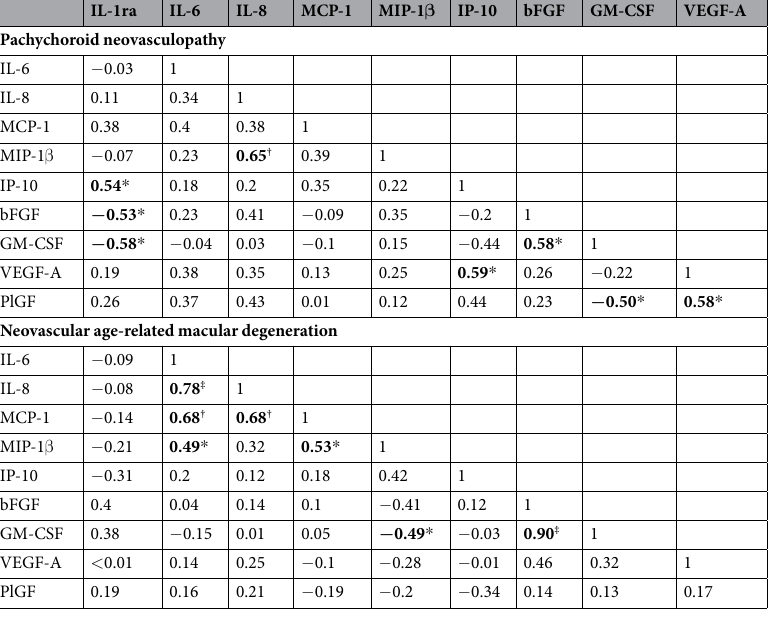
Table 3. Spearman’s Rank Correlation Coefficient for Ten Cytokines in Patients with Pachychoroid Neovasculopathy (a) and Neovascular Age-related Macular Degeneration (b). * P < 0.05, † p < 0.01, ‡ p < 0.001, p < 0.05 were considered significant (bold). IL-1ra = interleukin 1 receptor antagonist; IL = interleukin; MCP-1 = monocyte chemoattractant protein 1; MIP-1 β = macrophage inflammatory protein 1 β ; IP-10 = interferon- γ -induced protein 10; bFGF = basic fibroblast growth factor; GM-CSF = granulocyte macrophage colony-stimulating factor; VEGF-A = vascular endothelial growth factor A; PlGF = placental growth factor. Other cytokines were below the detection